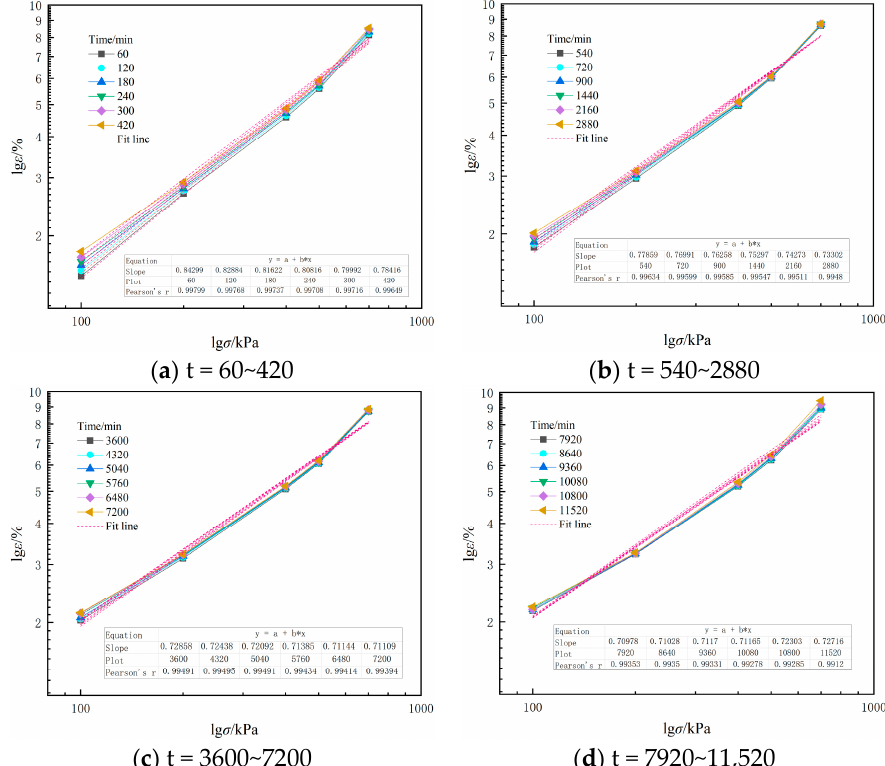
Figure 10. lg σ -lg ε relation and its linear fitting curve of Changsha sandy soil at different times.